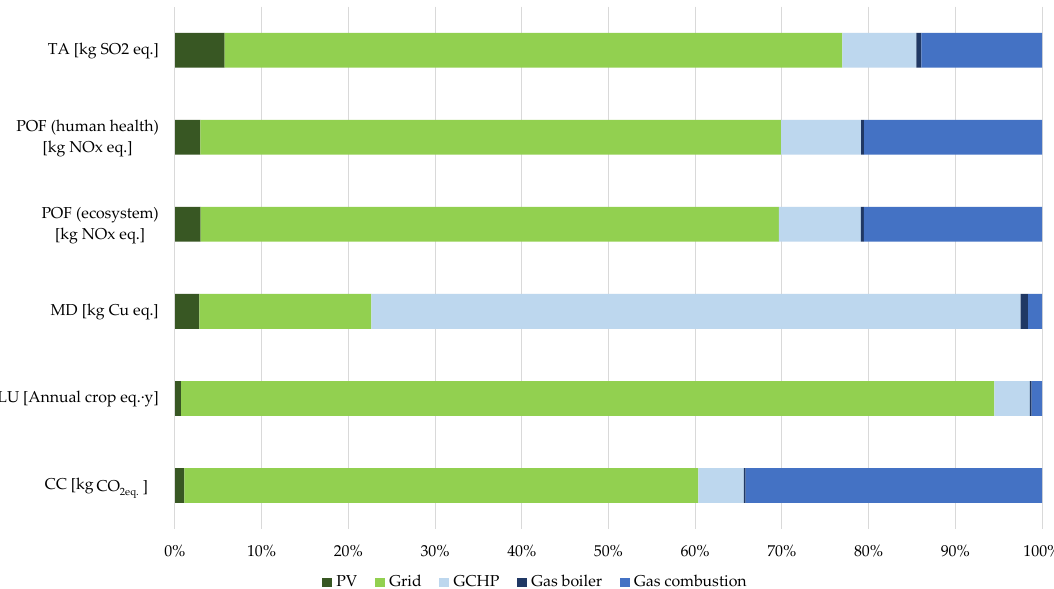
Figure 6. Results of cost-optimized, percentage distribution, and midpoint level. Abbreviations: CC = climate change, LU = land use, POF = photochemical ozone formation, TA = terrestrial acidifica- tion, MD = metal depletion.